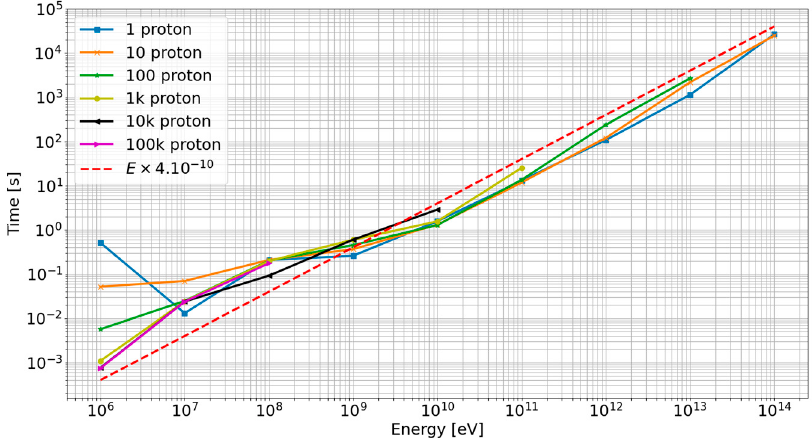
Figure 9. Average time of calculation of one primary particle Extensive Air Shower according to its energy and the number of primary particles simulated. energy and the number of primary particles